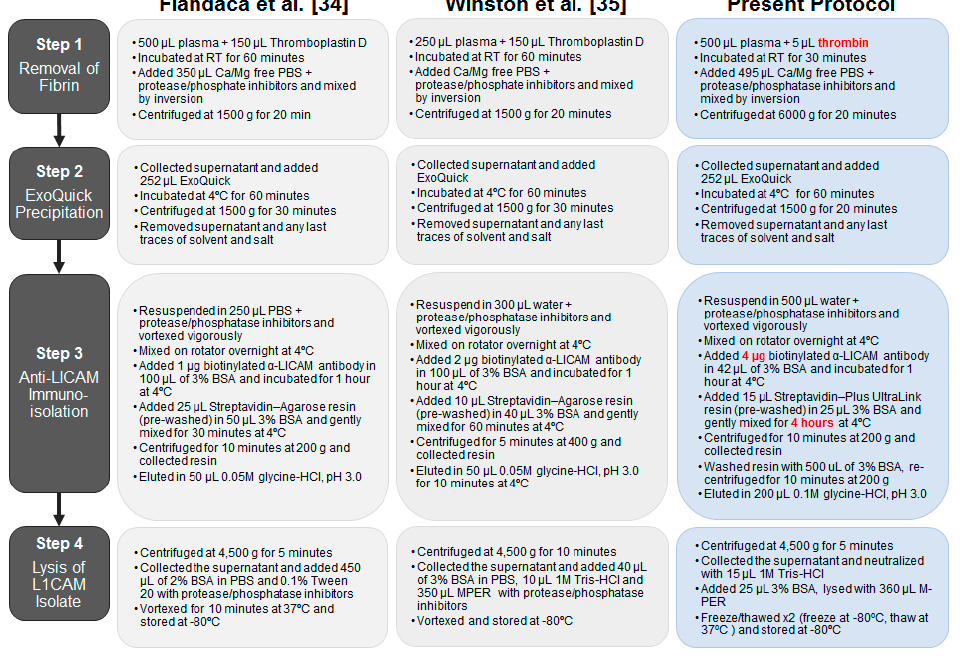
Figure 5. Comparison of published protocols used to isolate neuronal exosomes from blood and the method implemented in the present study. Preliminary studies revealed 2 steps (see red text) which critically influenced the production and analysis of neuronal exosomes: (i) the use of recombinant thrombin instead of thromboplastin D, and (ii) an increased amount of biotinylated anti-L1CAM and longer incubation time with streptavidin resin.